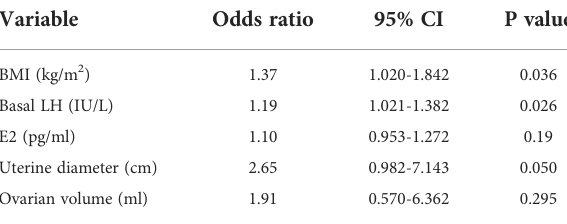
TABLE 4 Binary logistic regression analysis of the parameters related to